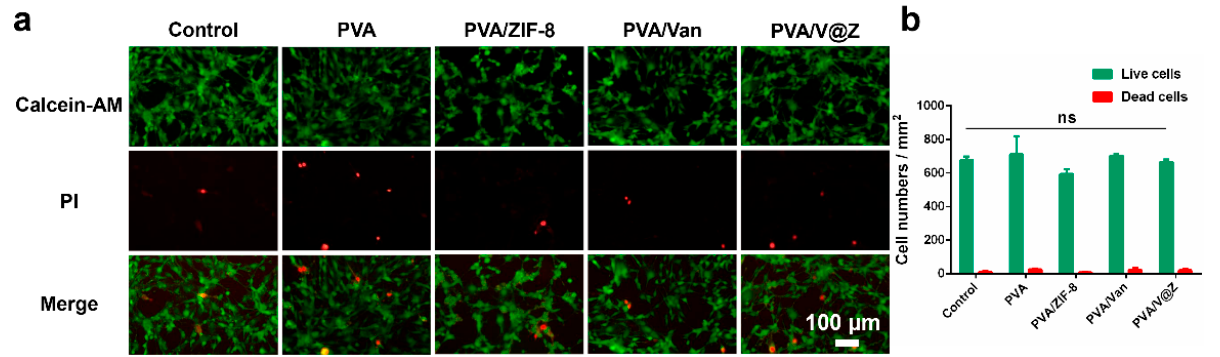
Figure 7. ( a ) Images of live/dead staining of MC3T3-E1 cells after being co-cultured with different fibrous membrane extracts for 24 h. Calcein–AM (green): live cells. PI (red): dead cells; Merge: merged channel of live/dead cells. ( b ) Statistical quantification of the cell number, n is the number of confocal pictures analyzed (n = 5). (ns, not significant)